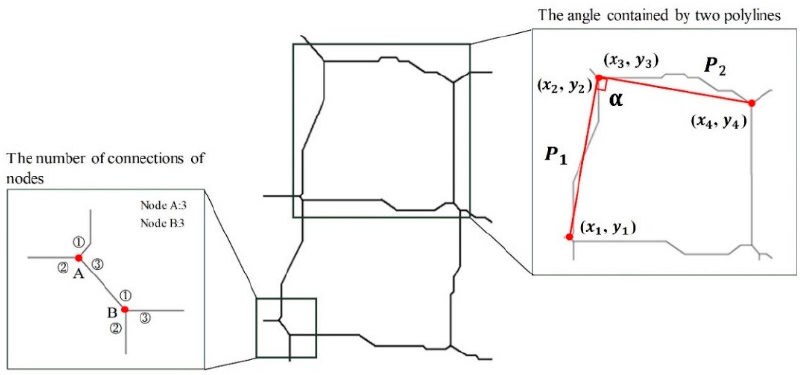
Figure 10. Skeleton line network features.